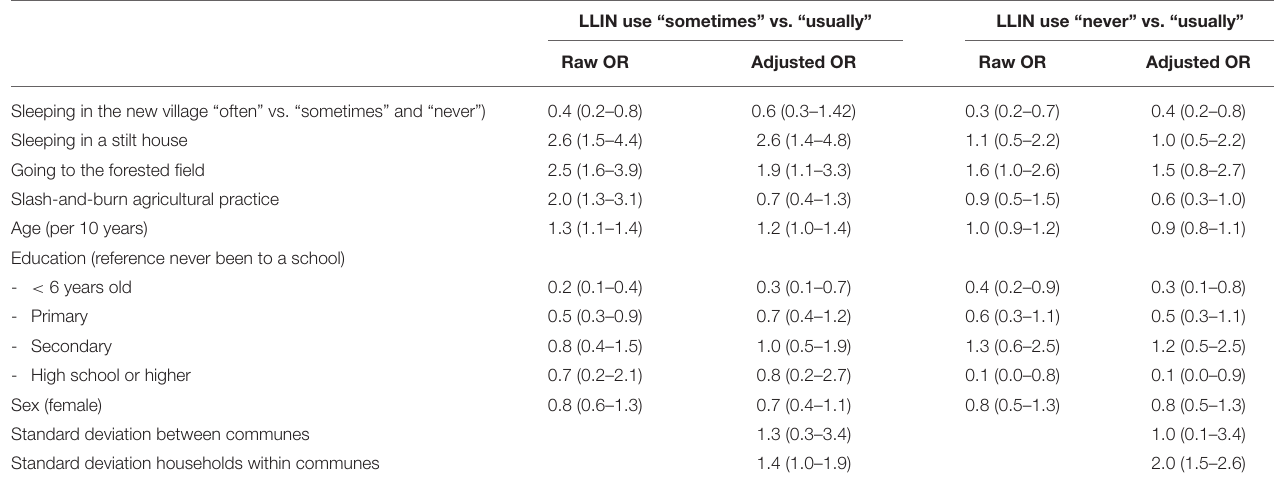
TABLE 4 | Risk factor analysis for inconsistent LLIN use in the last 7 days before the survey using multinominal logistic regression and the random effects for household and commune (AOR, CCI 95%, n = 1,925). LLIN use “sometimes” vs.